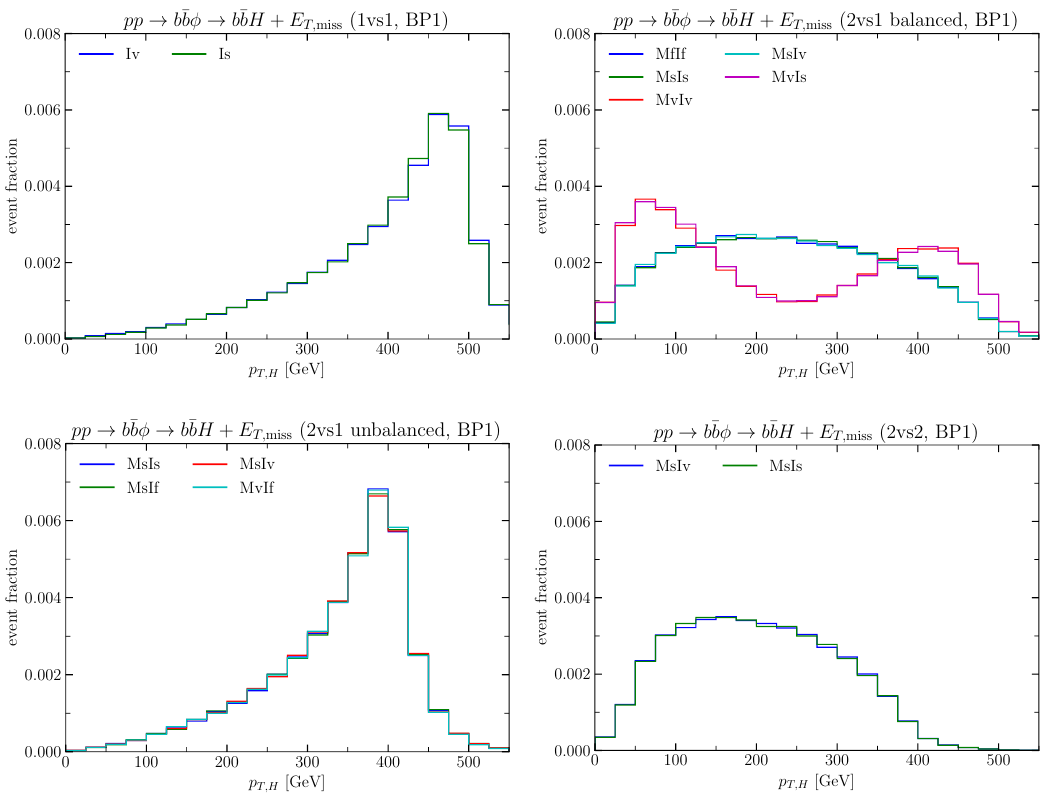
Figure 14. Mono- H + E miss final state: transverse momentum distribution of the di-gamma system T for BP1. The upper left panel displays the results for the 1vs1 balanced topology; the upper right panel for the 2vs1 balanced topology; the lower left panel for the 2vs1 unbalanced topology; and the lower right panel for the 2vs2